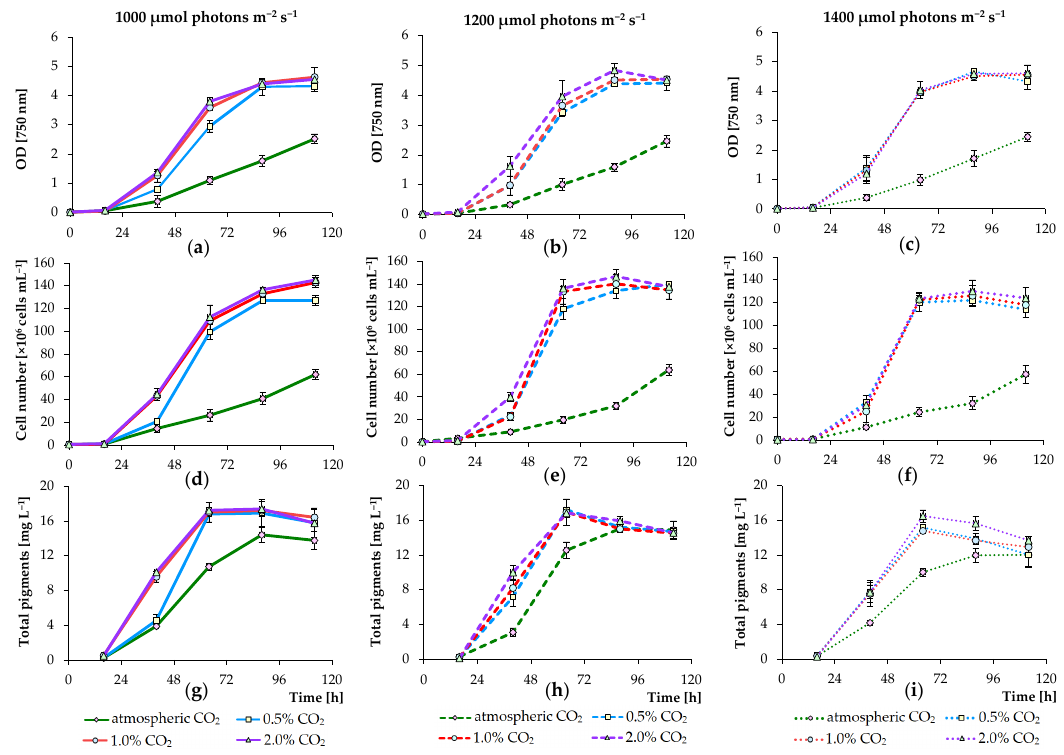
Figure 2. Growth of C. sorokiniana AM-02 (OD 750 ( a – c ) and cell number ( d – f )) and total pigment concentration in cells ( g – i ) cultured under various light and CO 2 regimens (1000, 1200, and 1400 µ mol photons m − 2 s − 1 and atmospheric CO 2 , 0.5, 1.0, and 2.0% CO 2 ) in standard Bold’s basal medium